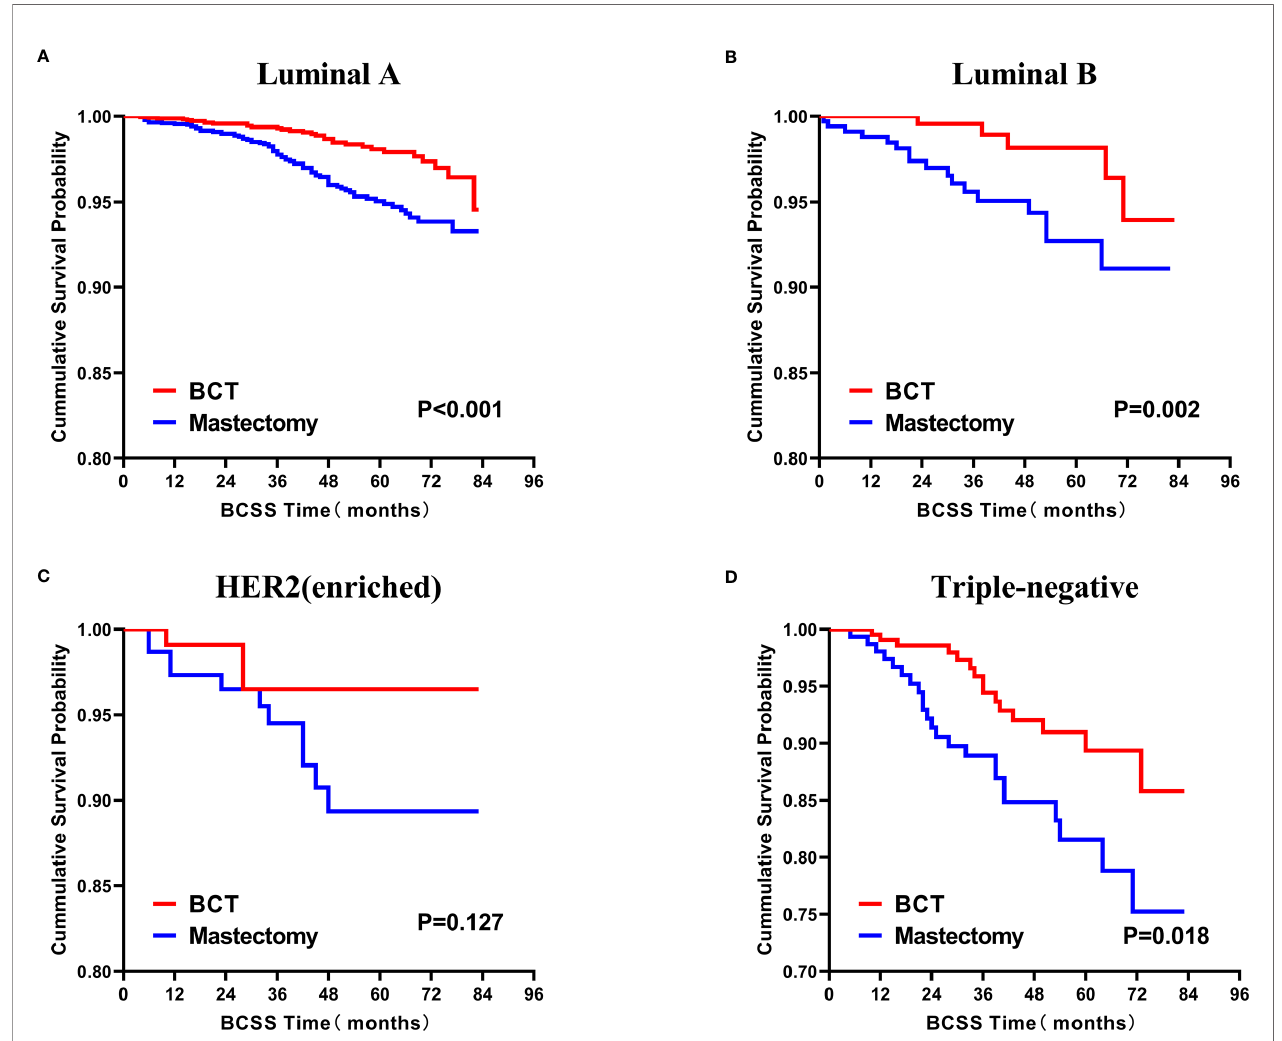
FIGURE 8 | Kaplan – Meier curves for BCSS by treatment type for all patients, strati fi ed by molecular subtype: (A) Luminal A. (B) Luminal B. (C) HER2 enriched. (D) Triple-negative. BCSS, breast cancer speci fi c survival; BCT, breast-conserving